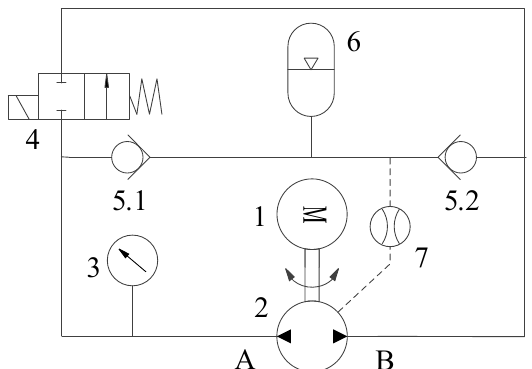
Figure 8. Schematic diagram of the dead zone pressure building experiment. 1: servomotor; 2: